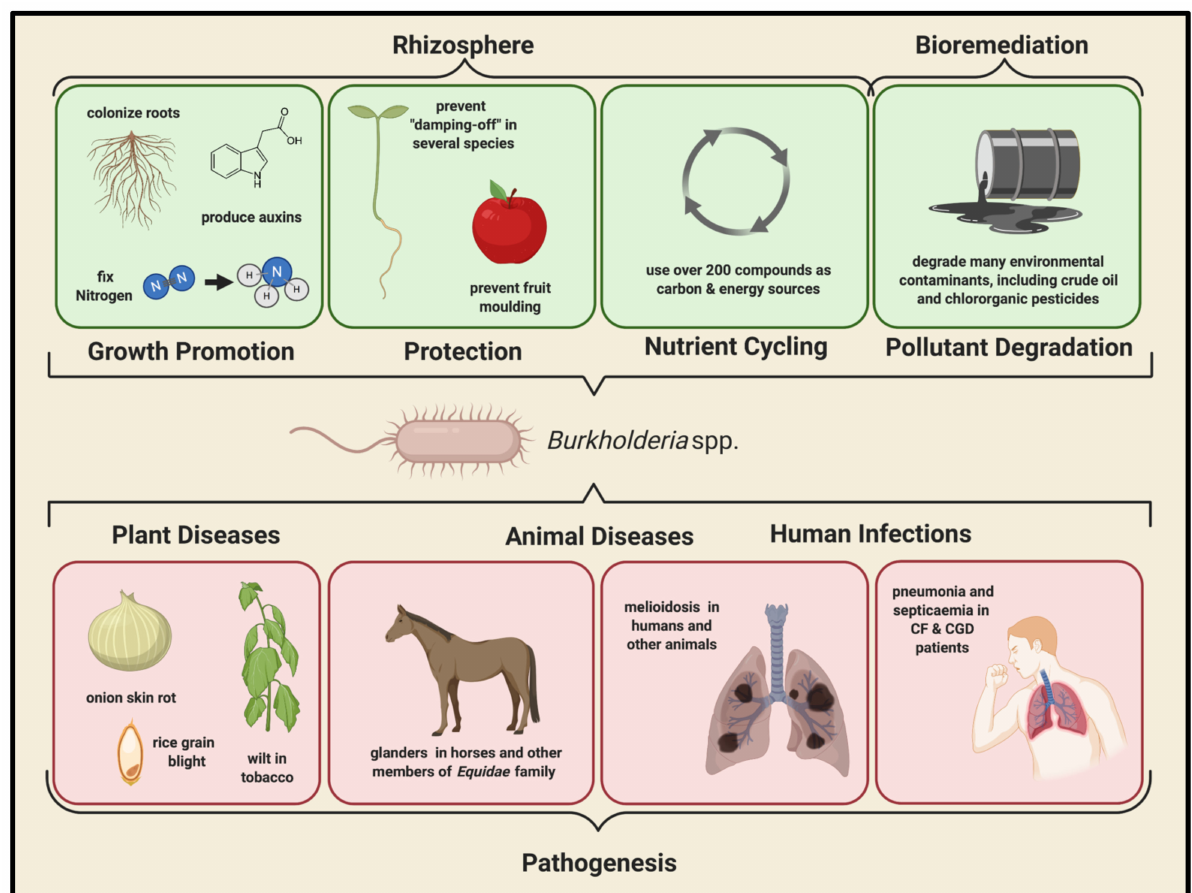
Figure 1. Environmental and pathogenic roles of Burkholderia species. Members of the genus Burkholderia have a wide range of roles in both environmental and clinical settings. Although many species directly promote plant growth, secrete antibacterial and antifungal agents to protect plants from infection from other organisms, and contribute heavily to soil nutrient flux, they are also known to cause disease in a number of crops including onions, tobacco, rice, as well as several species of flowering plants. Due to their impressive versatility with respect to carbon and energy sources, Burkholderia species have been investigated for use in bioremediation, and are known to be capable of breaking down several difficult-to-degrade contaminants. Unfortunately, several species within this genus are known to cause severe diseases in both human and non-human animals—including B. mallei —which causes glanders in horses and other animals; B. pseudomallei , the causative agent of melioidosis in humans and other animals; and members of the Bcc, which cause persistent, difficult-to-treat and often fatal lung infections in susceptible human